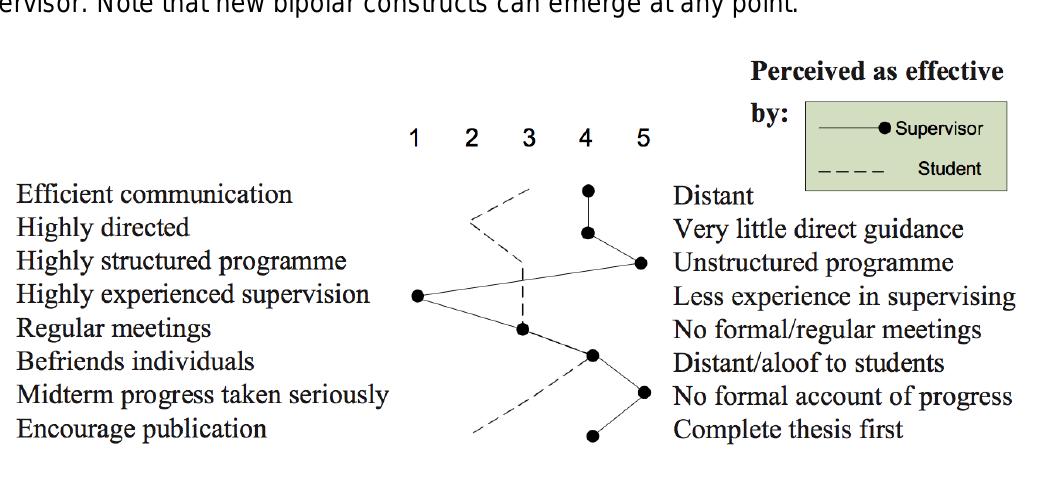
Figure 6 Further progress rating (i.e. data analysis / testing)